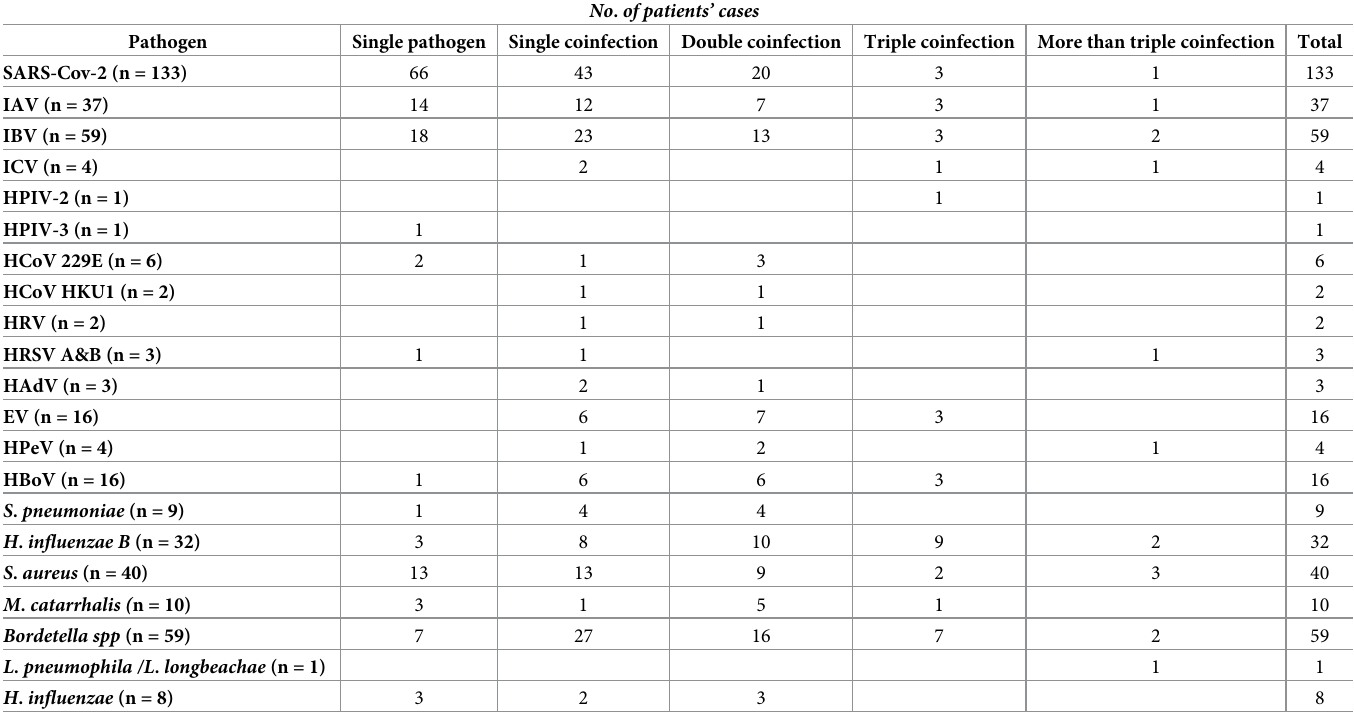
Table 4. List of single pathogen infections and pathogen-coinfections identified via FTD assay among all participants.